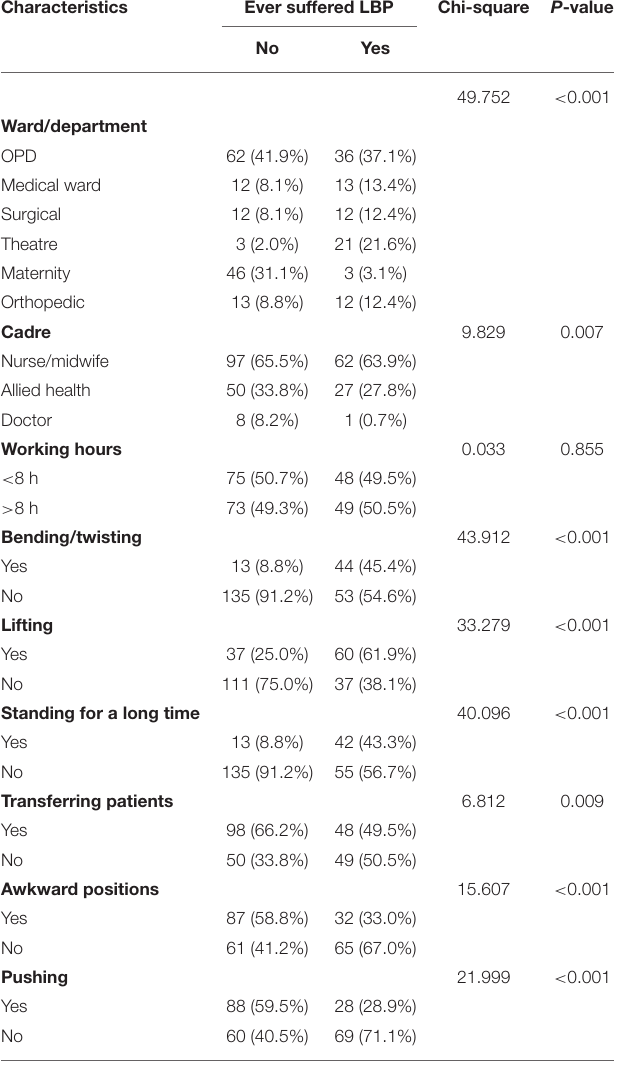
TABLE 3 | Bivariate analysis of work related factors associated with LBP.